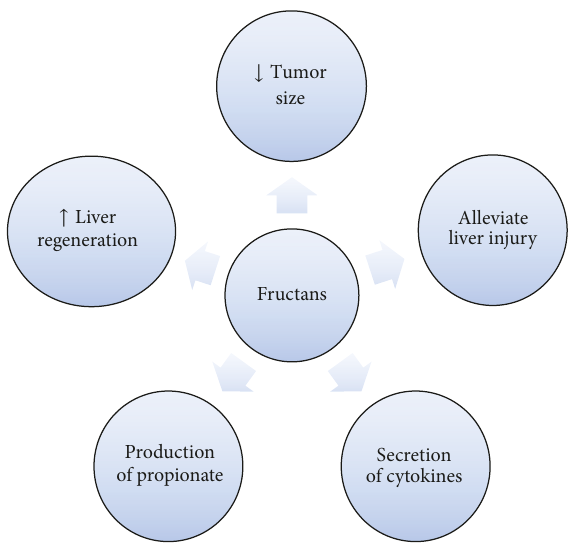
Figure 7: Antitumor properties of fructans